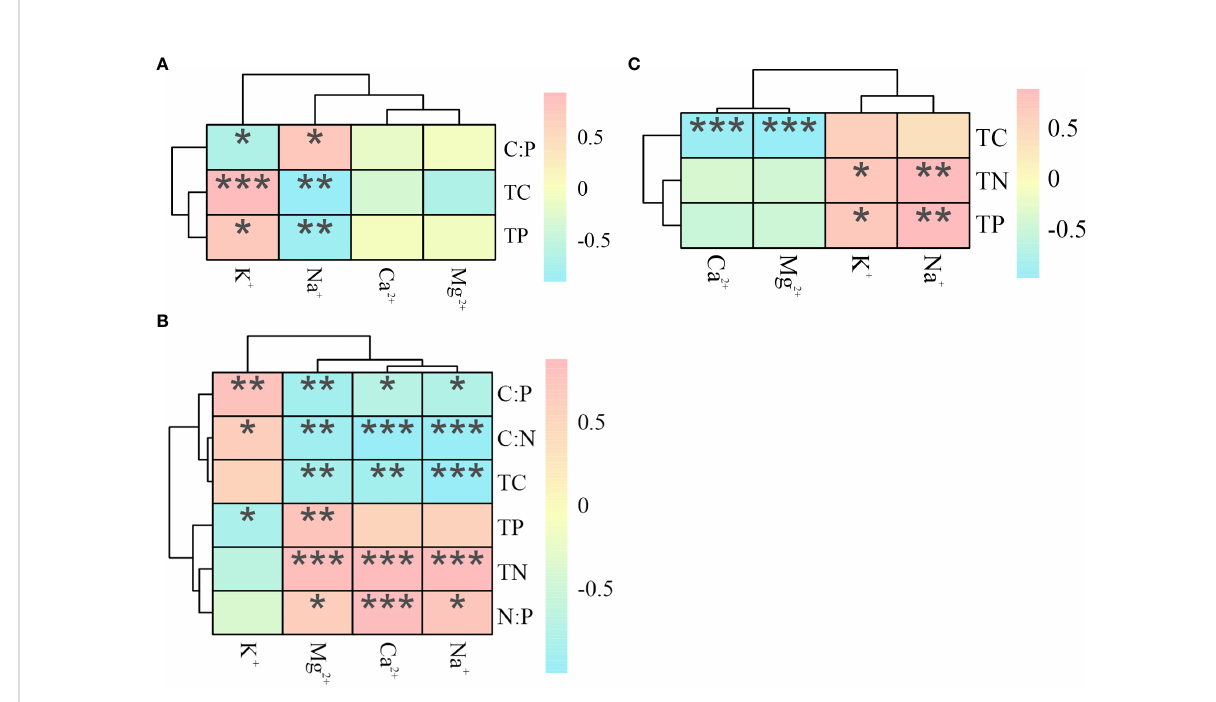
FIGURE 4 Heat map of the correlation between ecological stoichiometry and cations in P. communis (A) , S. salsa (B) and A. sinensis (C) . *, ** and *** represent signi fi cant differences at 0.05, 0.01 and 0.001 levels